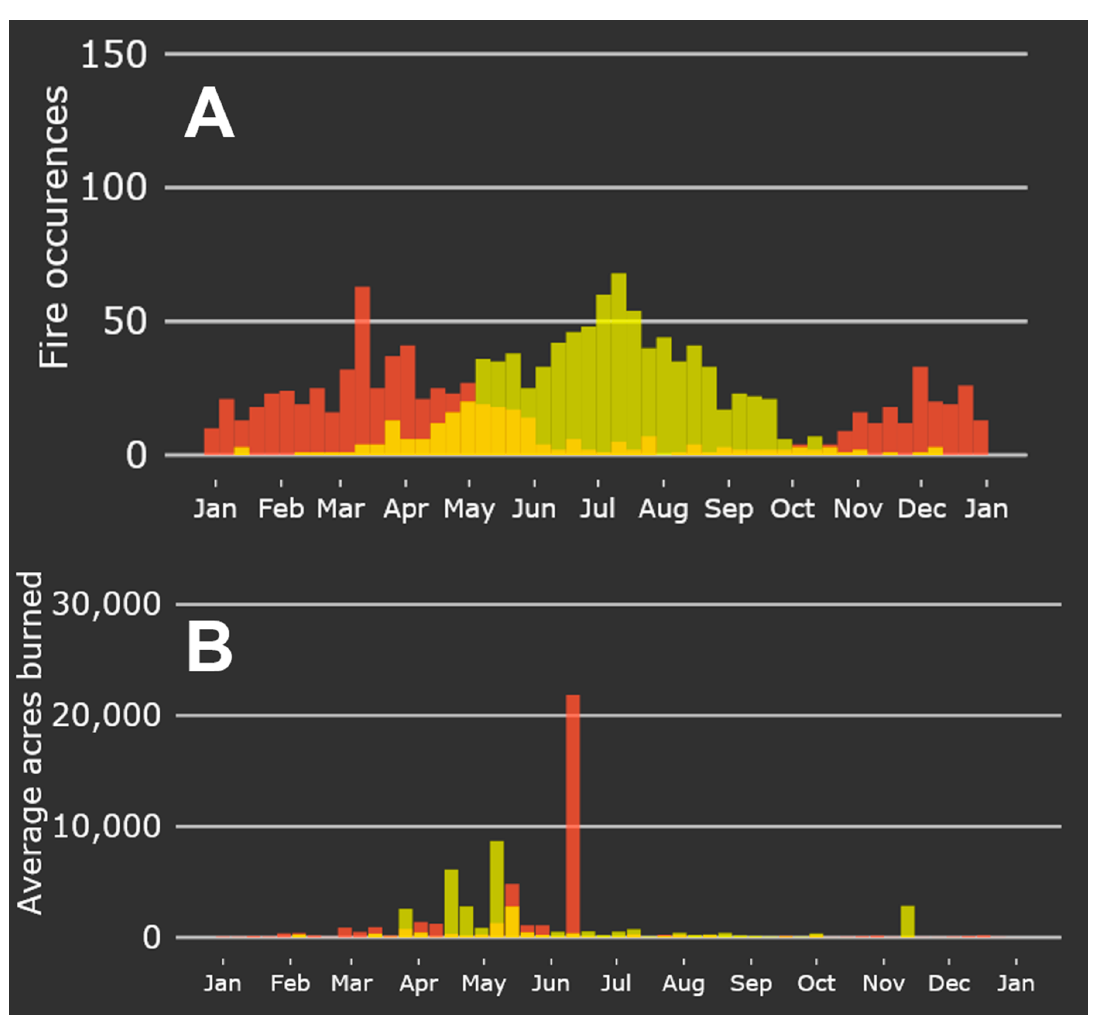
Figure 6. Average weekly fire occurrence (A) and acres burned (B) of human-caused wildfires (red) and natural wildfires (yellow) in Everglades National Park and Big Cypress National Preserve, 1980 to 2017. These two charts are linked to the primary visualization and display the fire sources highlighted by the user in the main visualization dashboard (Figure 3).